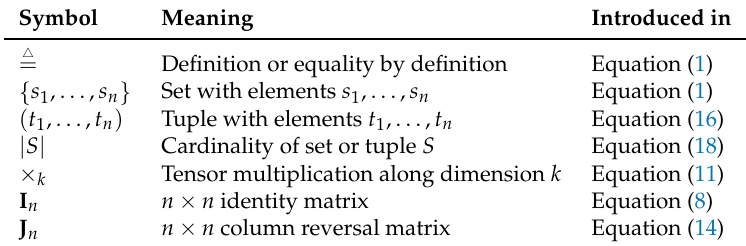
Table 1. Notation of this